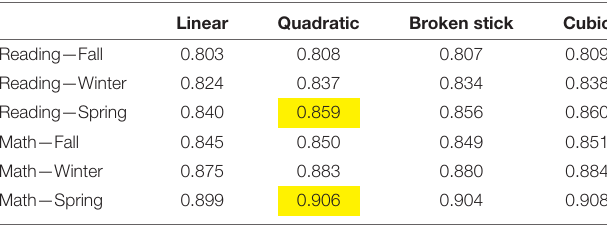
TABLE 3 | Correlations between predicted values and SBA for each of the MAPs and for both Reading and Mathematics. The predicted values are from a linear Tobit model, a quadratic one, the broken stick model, and a cubic model. Linear Quadratic Broken stick Cubic Reading—Fall